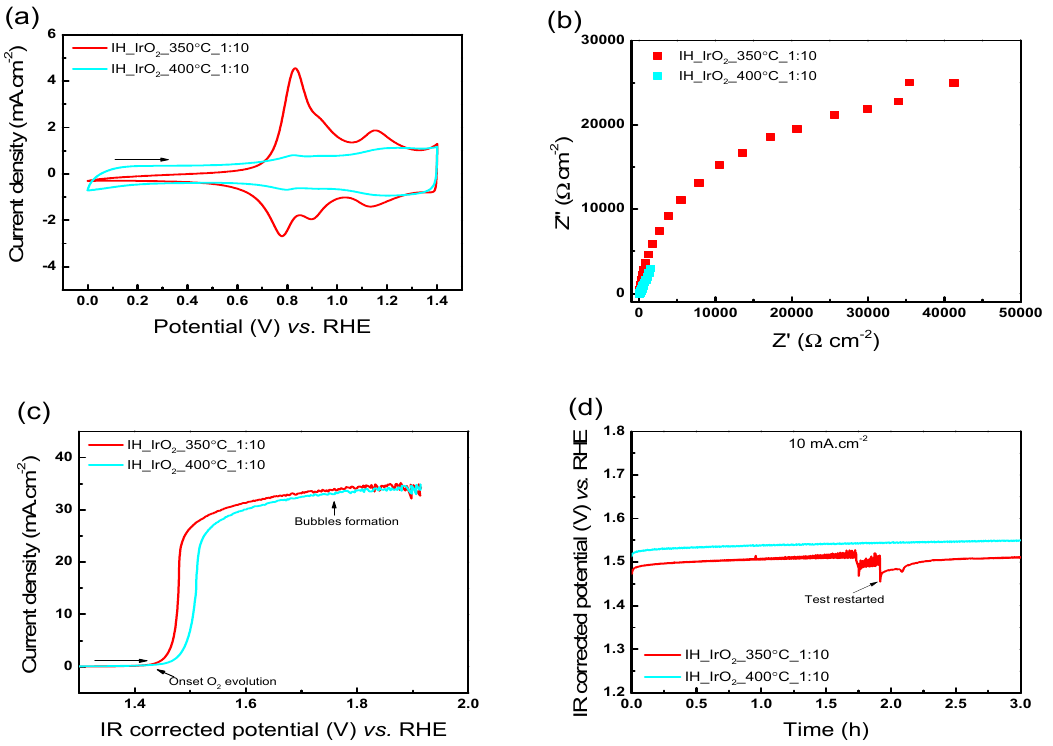
Figure 5. Electrochemical analyses of IH_IrO 2 _350 ◦ C_1:10 and IH_IrO 2 _400 ◦ C_1:10 ( a ) CV analysis at 20 mV · s − 1 potential scan rate, ( b ) EIS analysis, ( c ) LSV analysis at 2 mV · s − 1 and ( d ) CP analysis at 10 mA · cm − 2 .